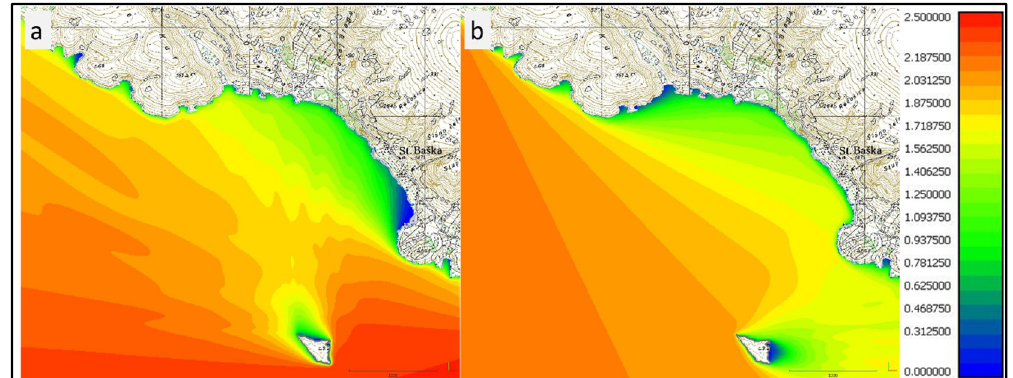
Figure 6. SWAN numerical simulations of the significant wave height (H S ): ( a ) Southeast (SE) and ( b ) Northwest (NW) wind directions, 50-year return period.